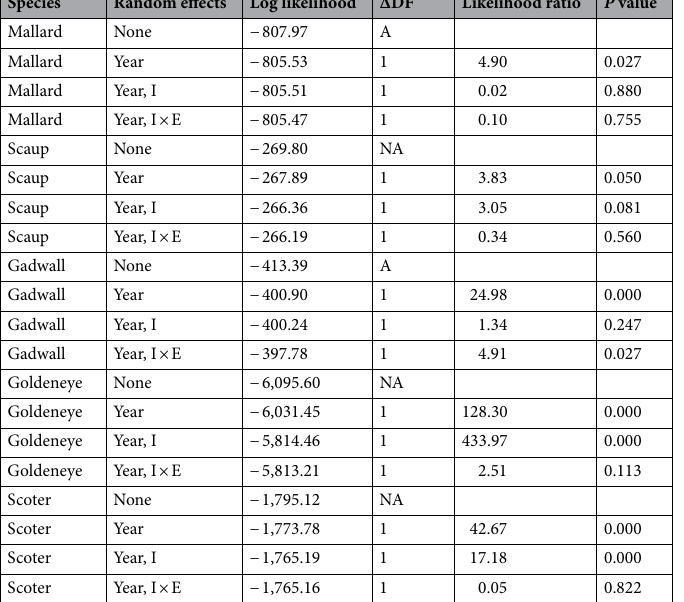
Table 1. Comparison of models for species-specific female plasticity in clutch initiation date. Likelihood ratio tests are used to sequentially test more complex models including random intercepts for ‘Year’ and individual females ‘I’, and random slopes for the female × spring temperature interaction ‘I × E’. Fixed effects are constant in all models, accounting for age, age 2 , and spring temperature. Estimates are based on females that made at least two inter-annual breeding attempts over their lifetime.